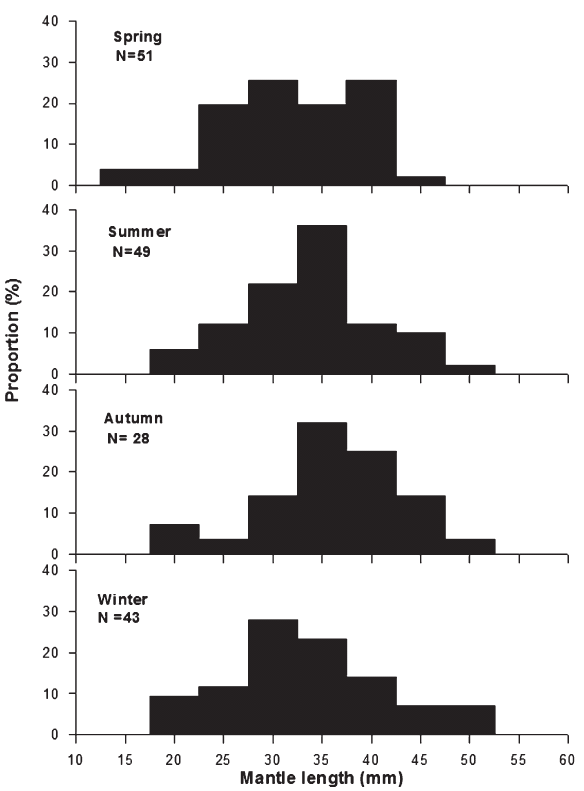
Fig . 2. – Seasonal distribution of Neorossia caroli in the Aegean Sea.